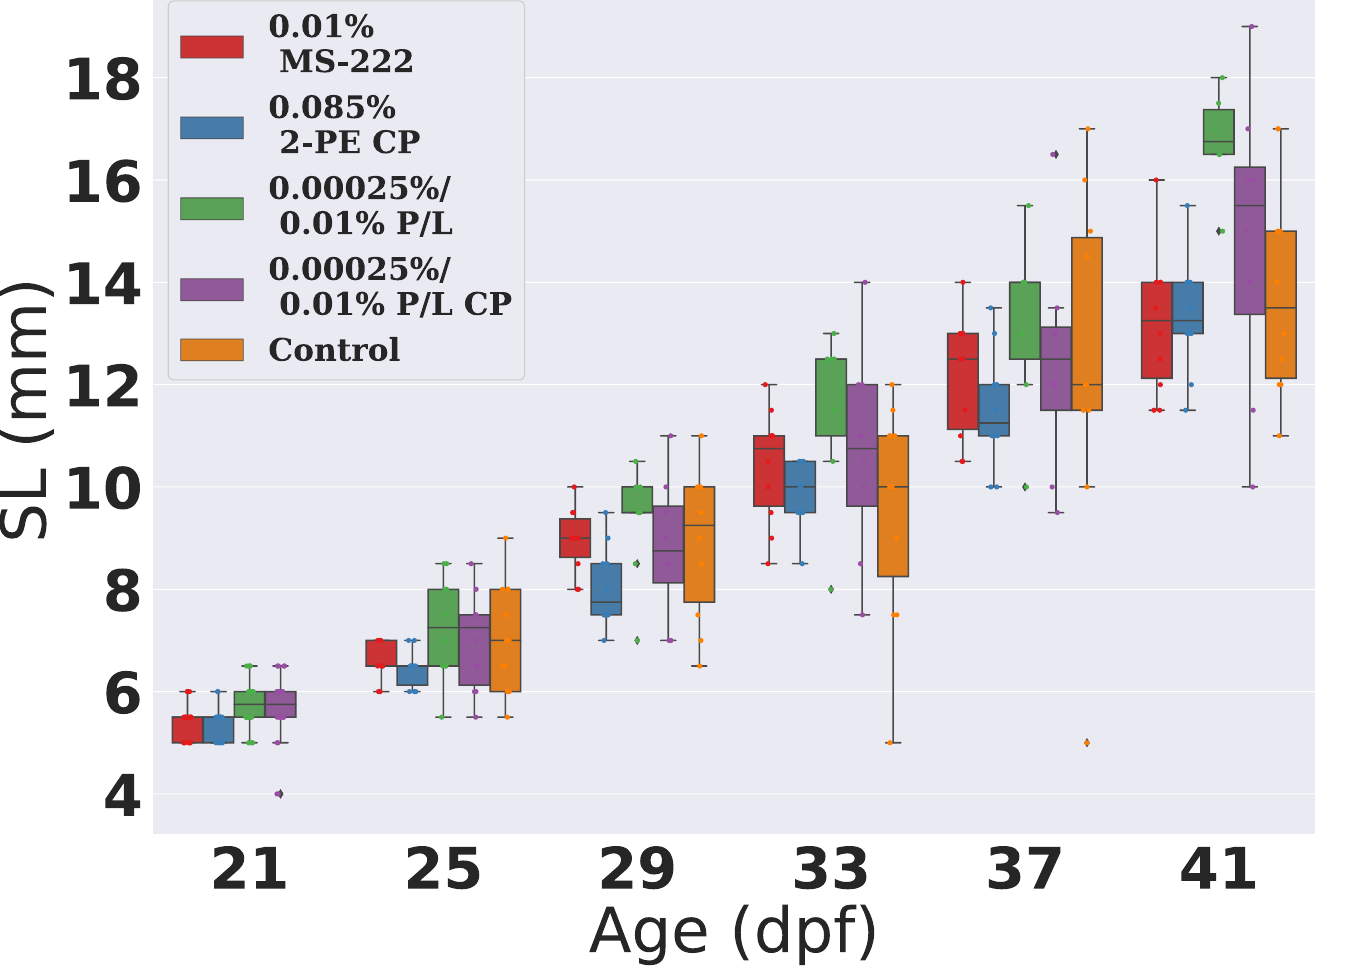
Fig 4. Growth of the fish is not significantly impacted by repeated dosing using any of the 4 protocols. Barchart with 95% confidence intervals for age vs length (SL (mm)) of fish anaesthetised using protocols 1,4,5 and 6 respectively.